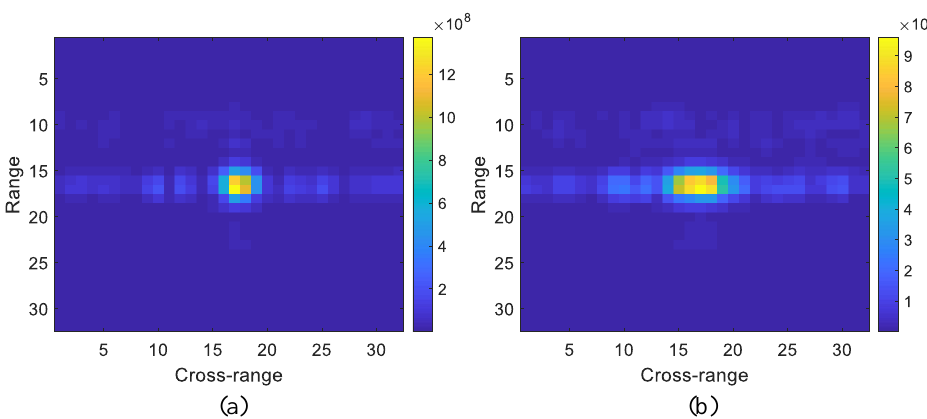
Figure 9. The imaging result of T1. ( a ) HPC-GMTIm (entropy = 2.97). ( b ) GHHAF method (entropy =